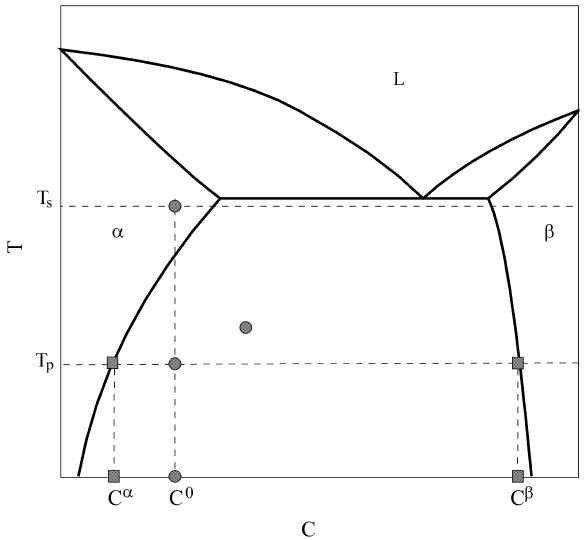
Figure 11. Typical phase diagram in which a precipitaion process can be made to